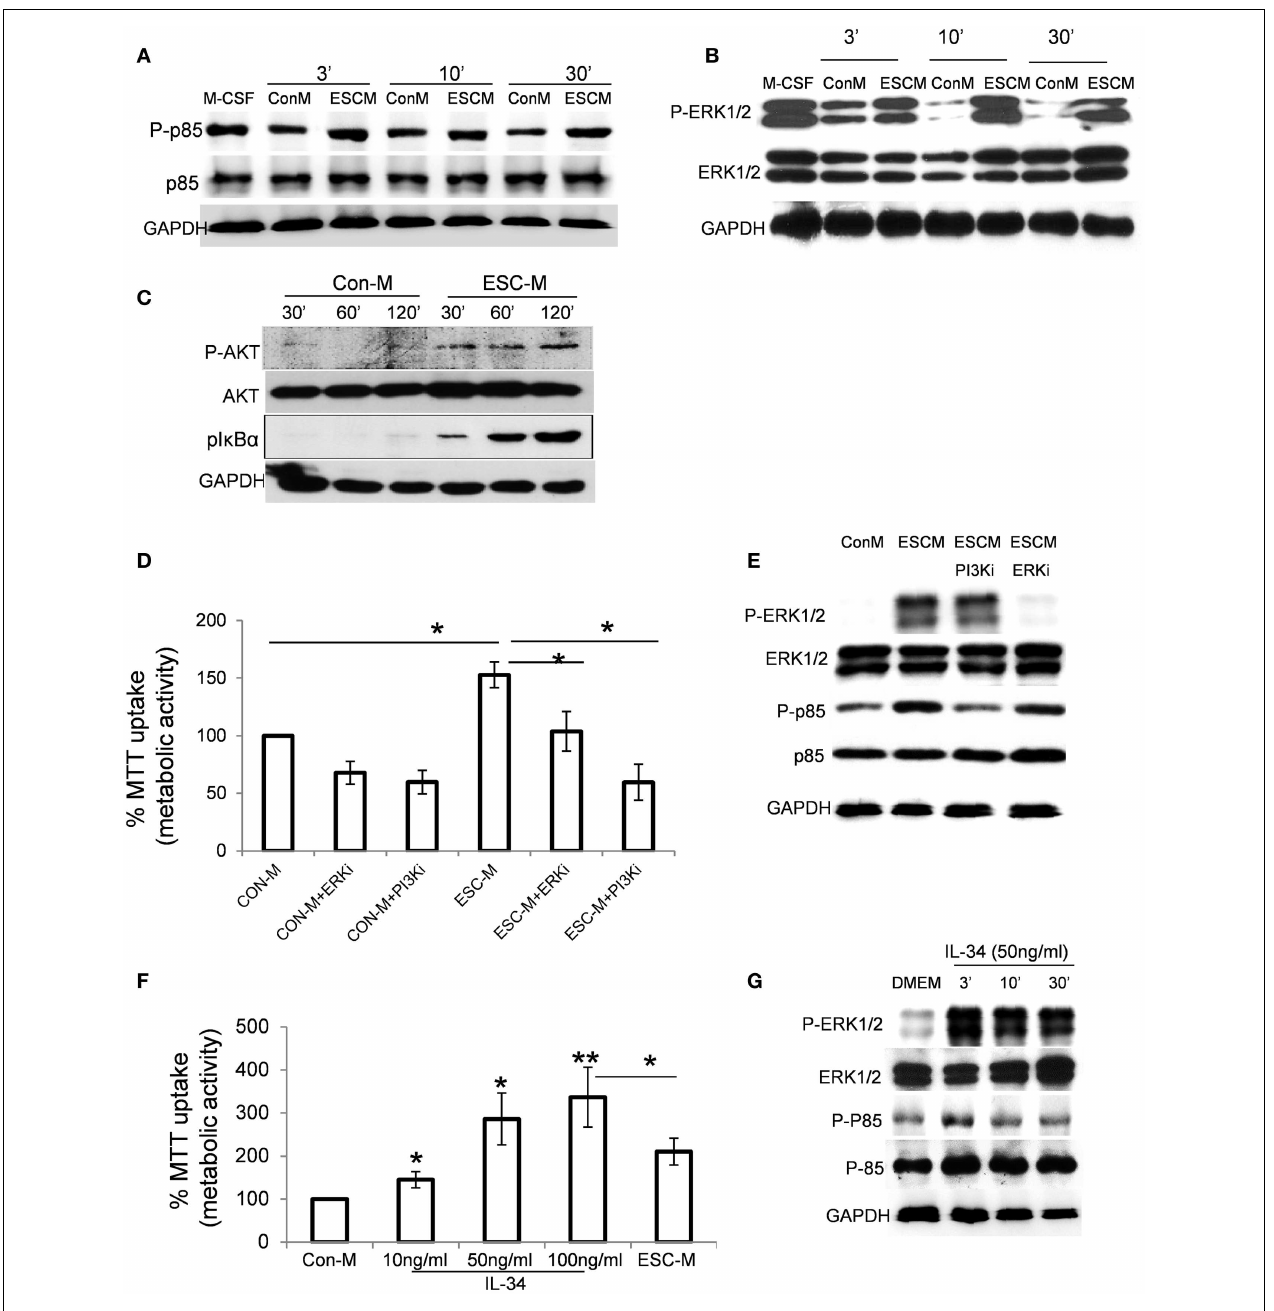
inhibitor LY-294002 (20 µ M) and ERK inhibitor PD98059 (10 µ M) for 30min and then treated with Con-M and ESC-M for 30min. Phosphorylation of p85 and p-ERK1/2 was detected byWestern Blot assay. (F) Effect of IL-34 on macrophage survival. BMDMs were incubated with mouse recombinant IL-34 at the indicated concentration for 48h.The metabolic activity of the cells was analyzed by the MTT assay and is presented relative to the activity of cells treated with Con-M ( n = 3, * p < 0.05; ** p < 0.001, ANOVA, data are represented as mean ± SEM). (G) Phosphorylation of p85 and p-ERK1/2 in BMDMs treated with IL-34 (50ng/ml) for the indicated